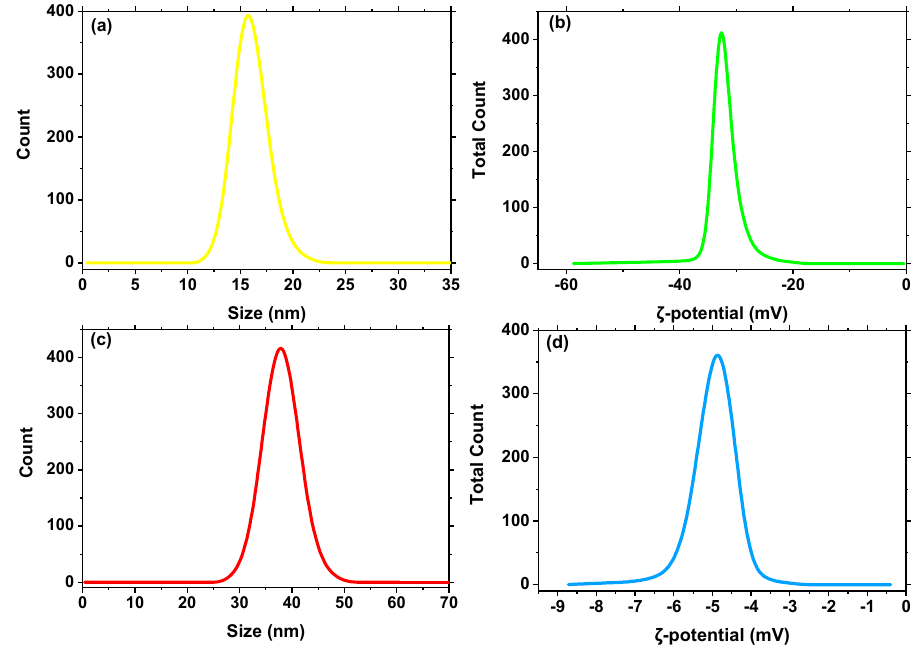
Figure 2. ( a , c ) Particle size distribution of green synthesized MgFe 2 O 4 NPs (yellow line) and MgFe 2 O 4 @CaAlg NCs (red line), ( b , d ) surface charge of green synthesized MgFe 2 O 4 NPs (green line) and MgFe 2 O 4 @CaAlg NCs (blue line), respectively.